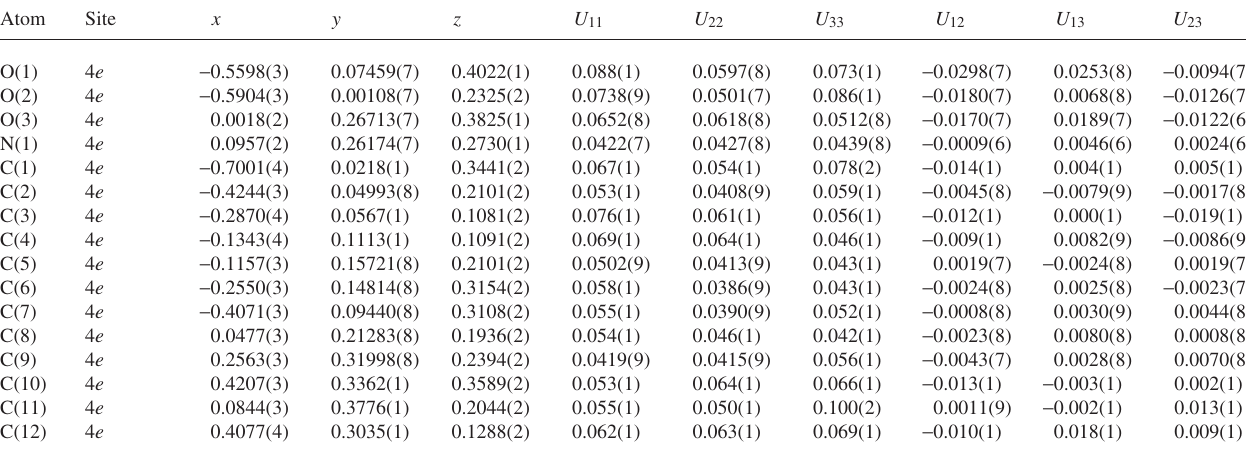
Table 3. Atomic coordinates and displacement parameters (in Å 2 )